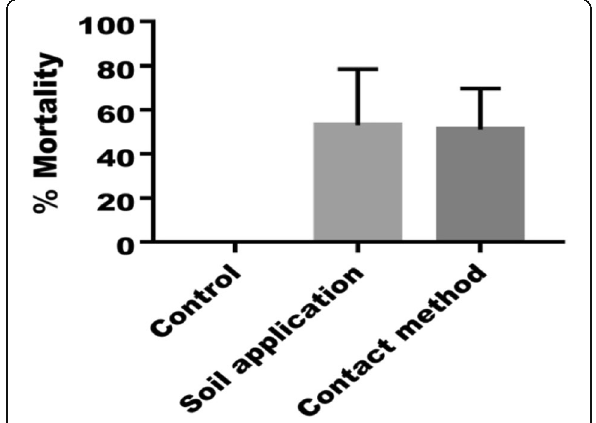
Fig. 1 M ο rtality percentage (mean ± SEM) ο f Ceratitis capitata lar ν ae treated with Steinernema